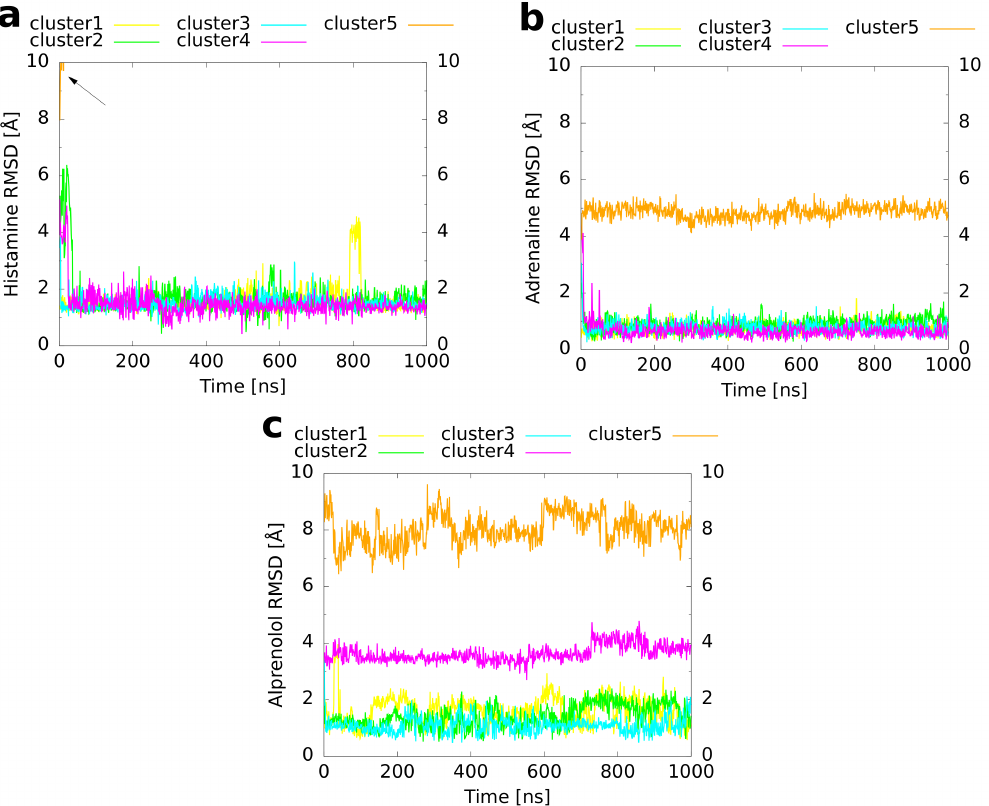
Figure 6. RMSD of the ligand heavy atoms compared to the reference binding mode. The RMSD is plotted as a function of simulation time for the unbiased MD simulations of the cluster representatives. A preceding fit to the protein backbone, but not to the ligand coordinates was performed. ( a ) Histamine in complex with the H 1 receptor, ( b ) adrenaline, and ( c ) alprenolol both in complex with the β 2 adrenoceptor. The arrow in panel ( a ) marks the rapid increase of the histamine RMSD of cluster 5 due to the dissociation of the ligand from the